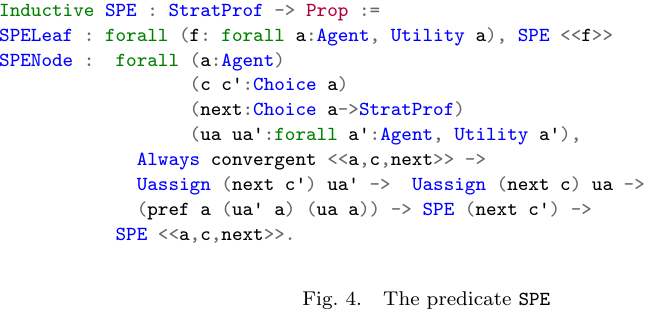
Fig. 3. Picture of game with finite histories and no longest history